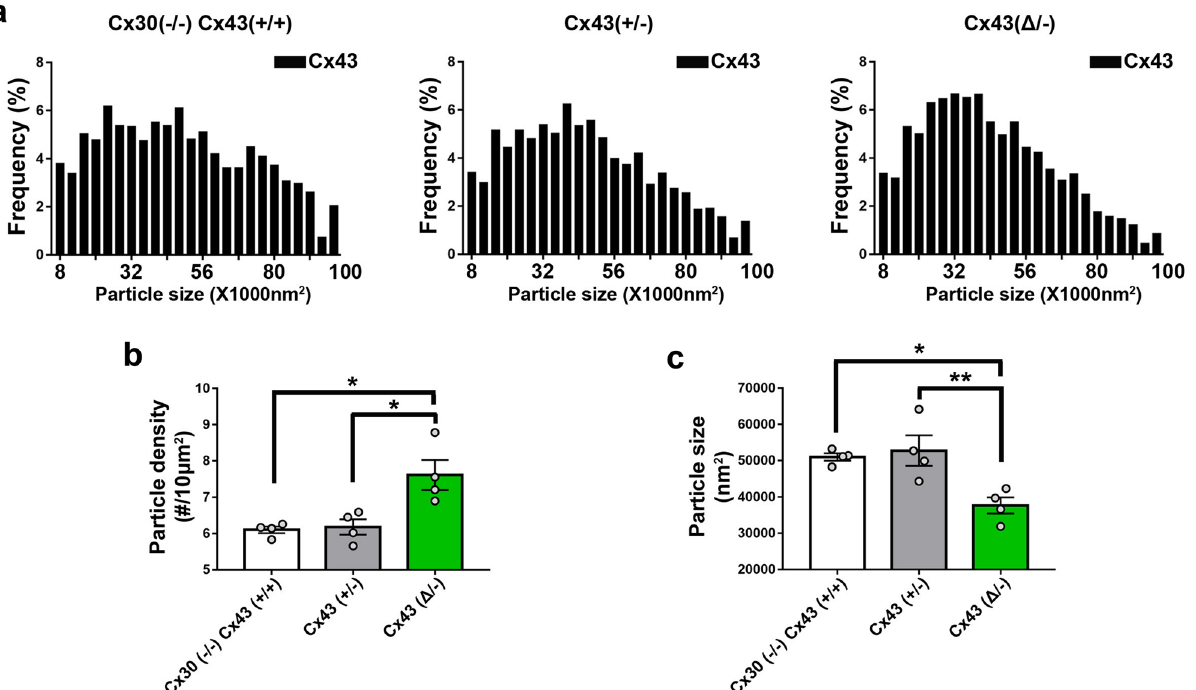
Figure 4. Distribution of Cx43 in endfeet of Cx43 transgenic mice. ( a ) Histograms showing size distribution of total number of particles obtained from 6–10 images of brain sections from each genotype (n = 4 mice, 1500–2000 particles analyzed from each genotype). ( b ) Comparison of Cx43 plaque densities for each of the transgenic lines (n = 4 mice, 6–10 images from each genotype). ( c ) Geometric means of particle sizes for perivascular Cx43 in each genotype (n = 4 mice, 6–10 images from each genotype). Data are presented as mean ± SEM (ANOVA followed by Tukey’s post hoc test: * p < 0.05, ** p <